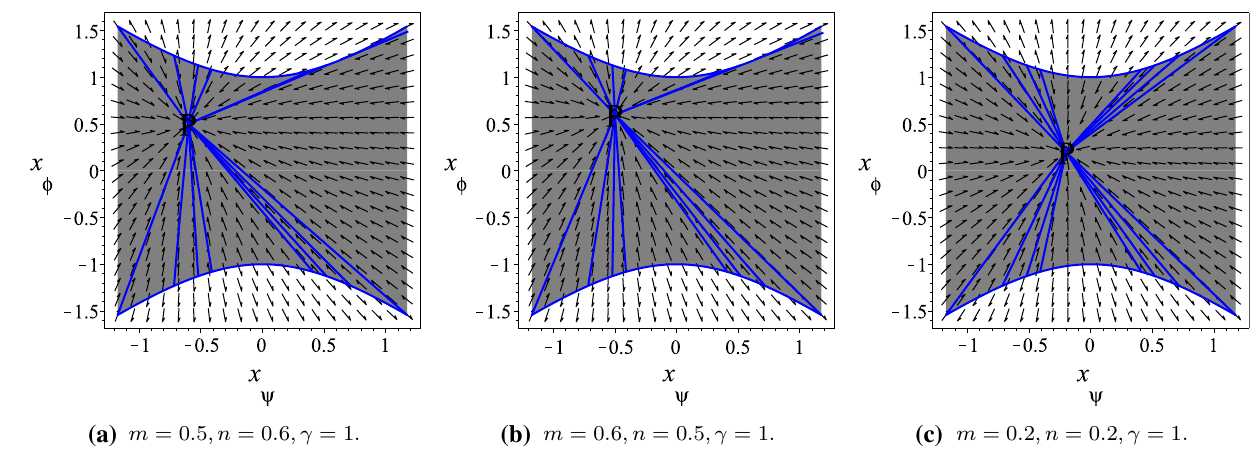
Fig. 2 Some orbits in the phase plane of the system (20)–(21) for three choices of the